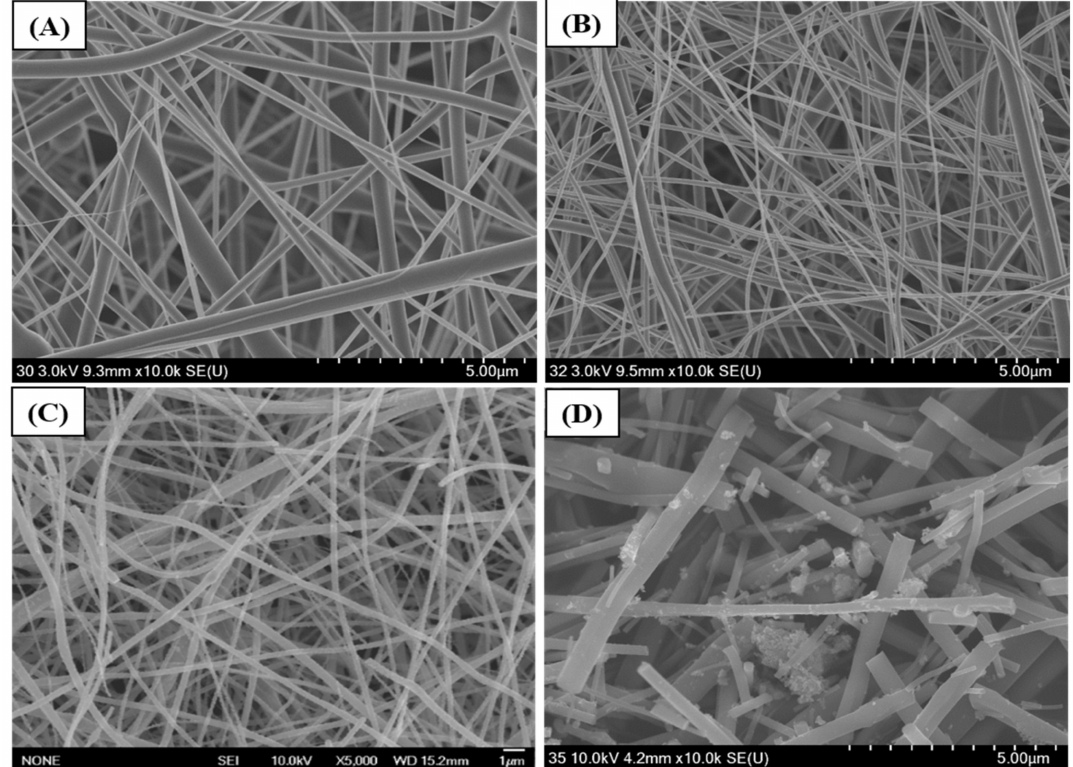
Figure 1. Field emission scanning electron microscopy (FESEM) images of titanium tetraisopropoxide / polyvinylpyrrolidone (TTIP / PVP) nanofibers ( A ), titanium dioxide (TiO 2 ) NFs ( B ), TiO 2 -carbon